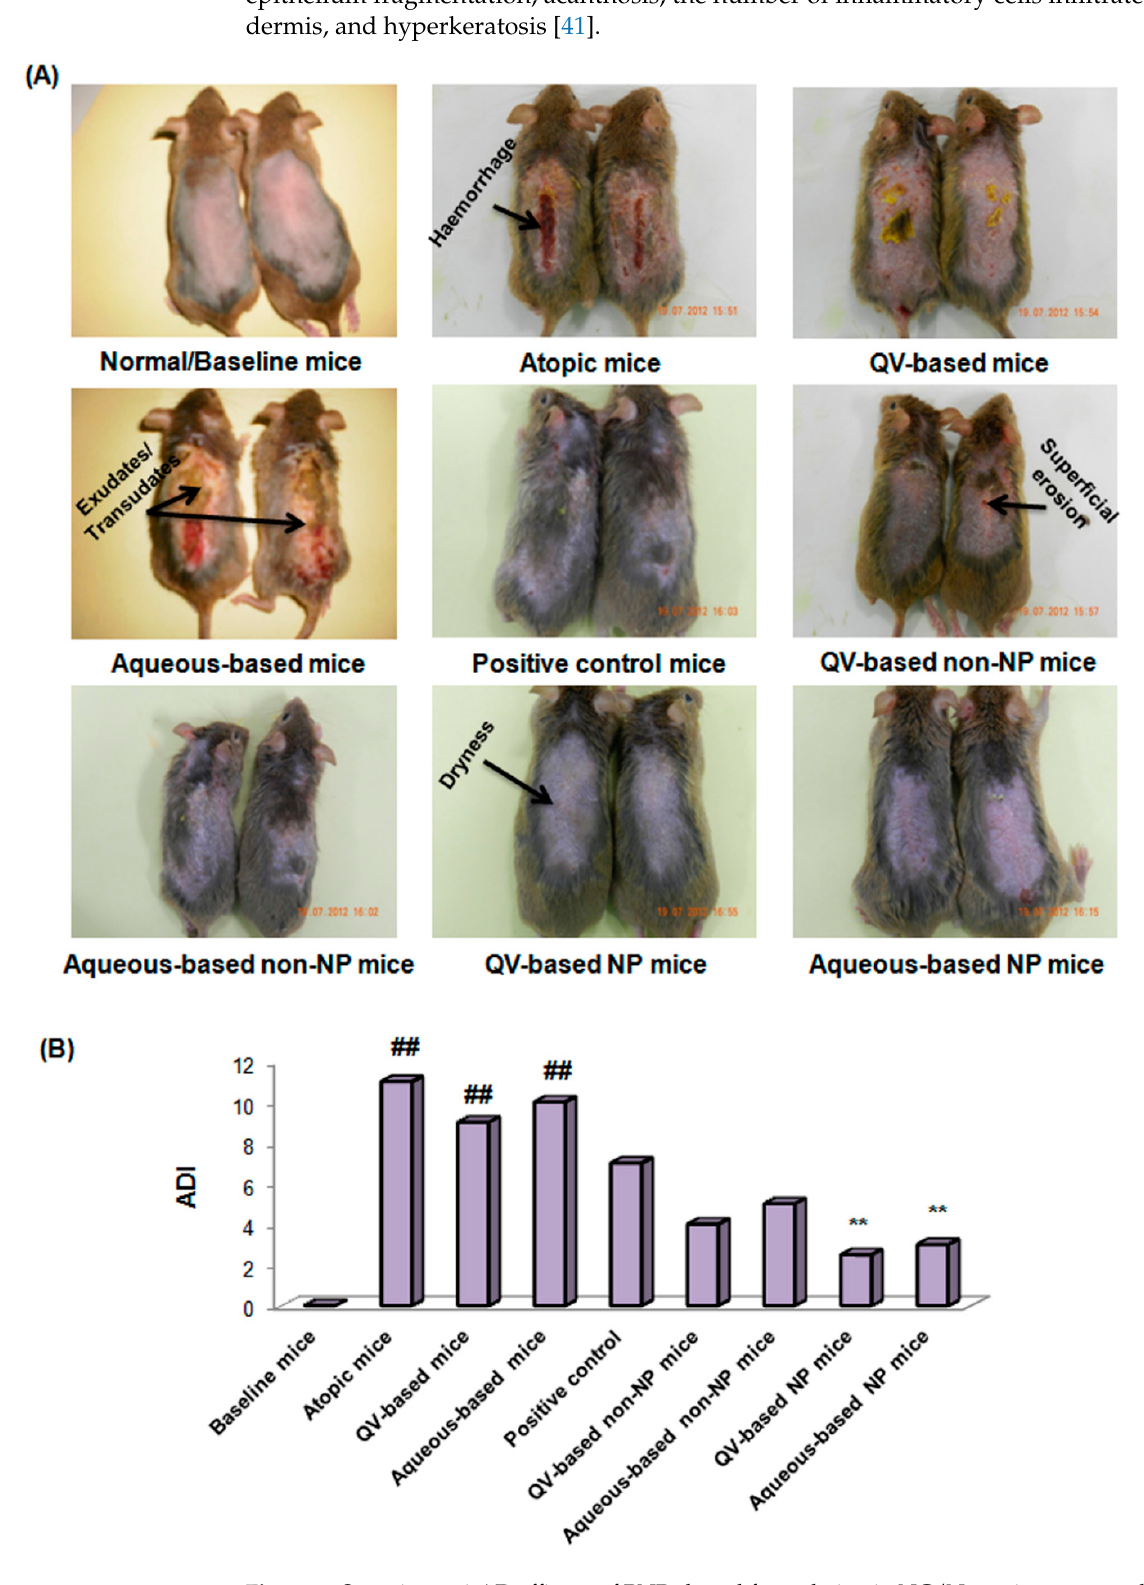
Figure 5. Superior anti-AD efficacy of PNPs-based formulation in NC/Nga mice compared to other treatment groups. ** p < 0.001, ## p < 0.005. Adapted from [41], PLOS, 2014. Digital images ( A ) and ADI ( B ) of untreated and treated AD-induced NC/Nga